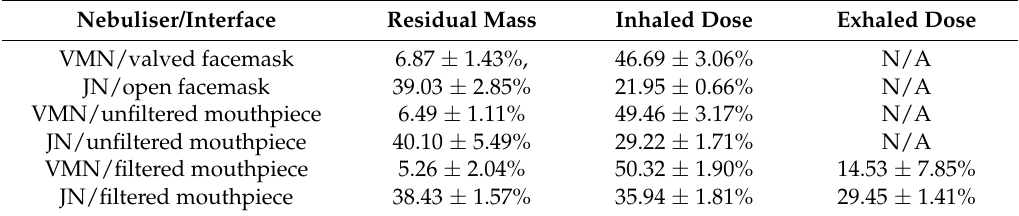
Table 1. Inhaled dose, exhaled dose and residual mass recorded during each nebulisation event (using facemask and mouthpiece); mean and standard deviations over the three events (results expressed as a percentage of the nominal dose placed in the nebuliser).